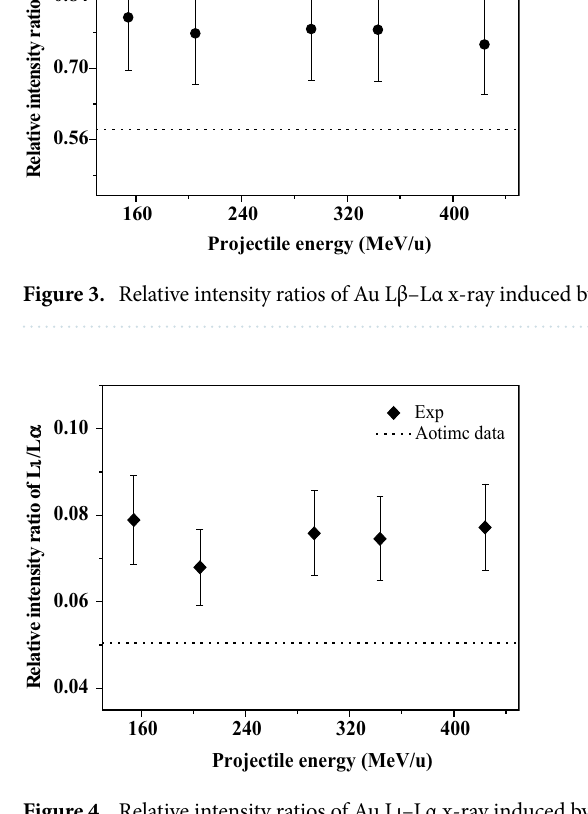
Figure 4. Relative intensity ratios of Au Lι–Lα x-ray induced by C 6+ ions at different incident